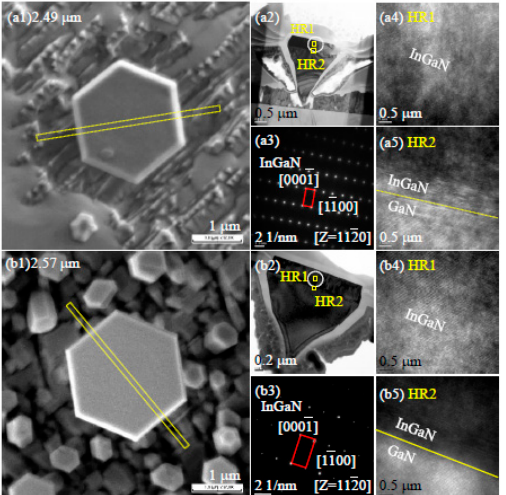
Figure 2. ( a1 ) The top view SEM image of the microdisk of Sample D and the cleavage plane along the [1100] direction (the scale bar is 1 µ m). ( a2 ) The TEM image of microdisk (the scalebar is 0.5 µ m). ( a3 ) The SAD pattern of In x Ga 1-x N layer with scale bar of 2 (1 / nm). ( a4 , a5 ) show the high-resolution TEM images of the GaN layer, and the interface between GaN layer and In x Ga 1-x N layer on microdisk, respectively. ( b1 ) The top view SEM image of the microdisk of Sample H and the cleavage plane along the [1100] direction (the scalebar is 1 µ m). ( b2 ) The TEM image of the microdisk (the scale bar is 0.5 µ m). ( b3 ) The SAD pattern of In x Ga 1-x N layer with scale bar of 2 (1 / nm). ( b4 , b5 ) show